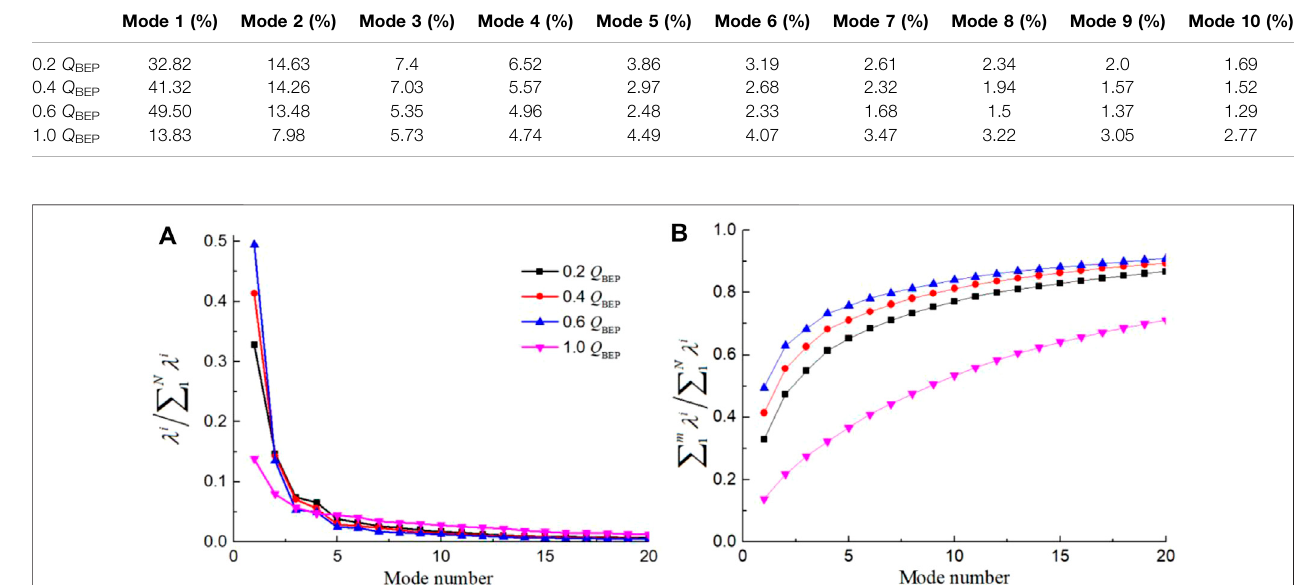
FIGURE 6 | (A) Energy contribution of each mode and (B) cumulative energy